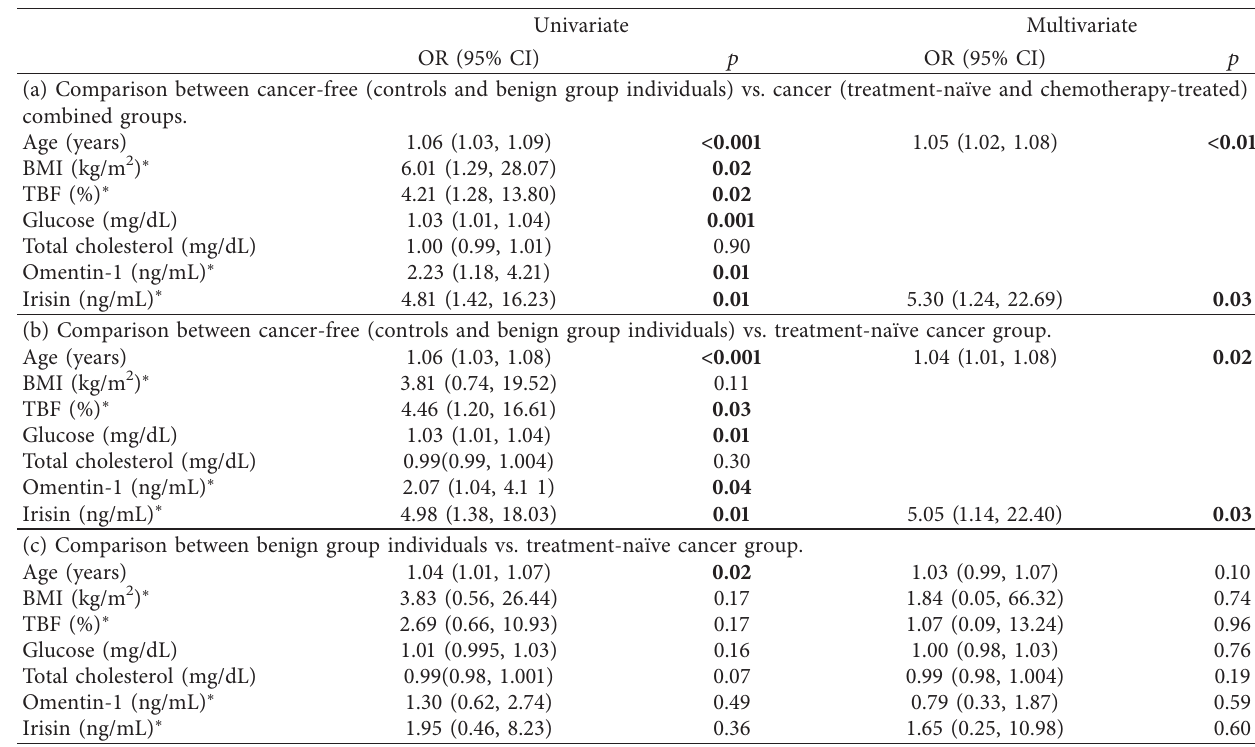
Table 3: Independent predictors for the presence of malignancy.